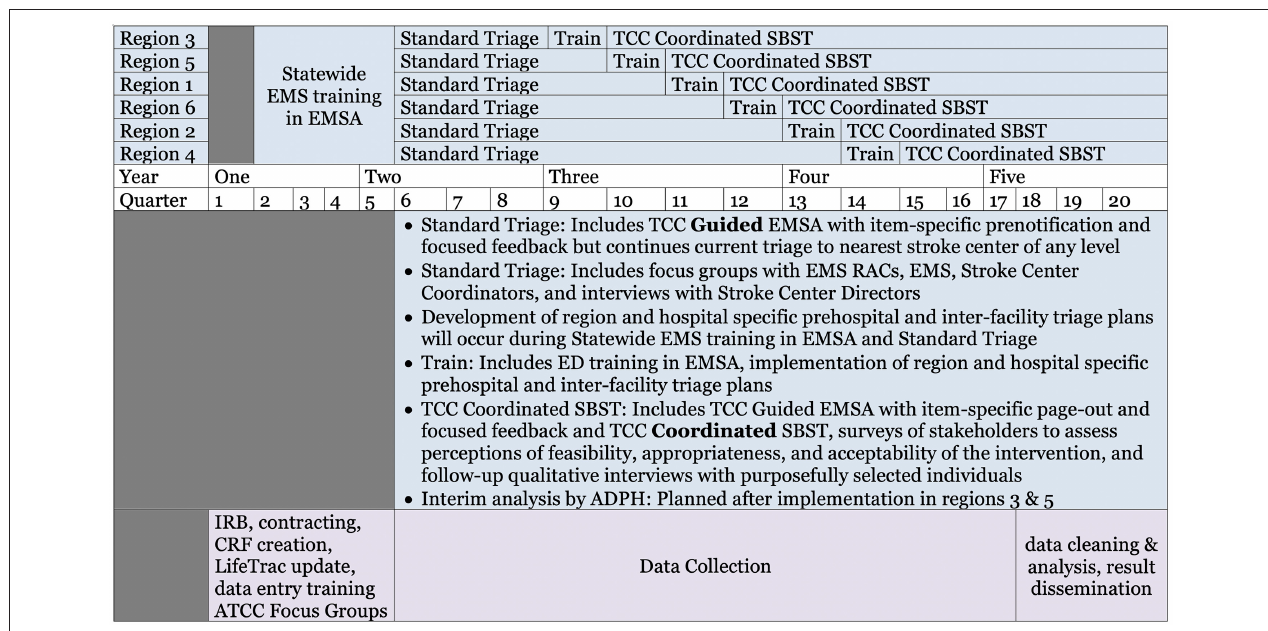
FIGURE 5 | Five year timeline. Stepped wedge cluster trial with each EMS region serving as a cluster. During Standard Triage periods, we will implement TCC Guided EMSA but continue current triage to the nearest stroke center of any level and conduct focus groups and interviews to aid in the development of region and hospital specific SBST plans. During the Train periods, we will conduct regional educational symposia and implement SBST plans. During TCC Coordinated SBST periods TCC will guide EMS in performance of the EMSA and coordinate SBST and we will conduct stakeholder surveys and interviews to assess context-specific perceptions of the